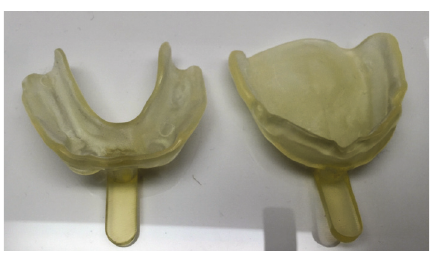
Figure 3: Special trays manufactured by rapid prototyping.